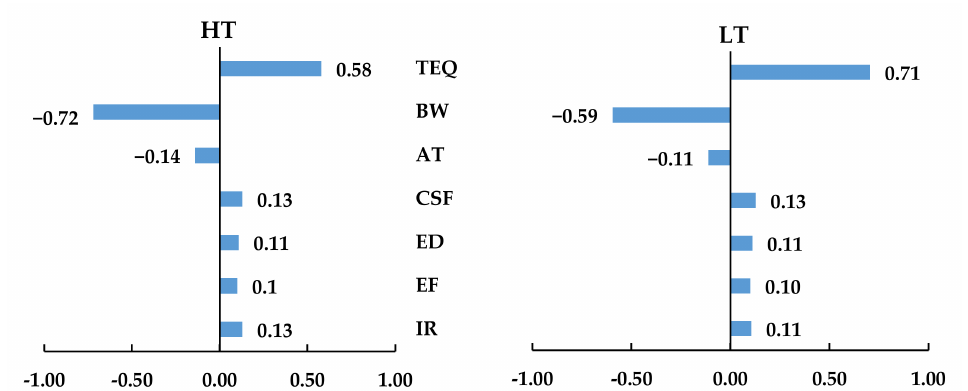
Figure 6. Sensitivity analysis of carcinogenic risk for children in HT and LT groups. TEQ = Toxic equivalent concentration; BW = Body weight; AT = Averaging time of carcinogenic PAHs expo- sure; CSF = Inhalation cancer slope factor; ED = exposure duration; EF = Exposure frequency; IR = Inhalation